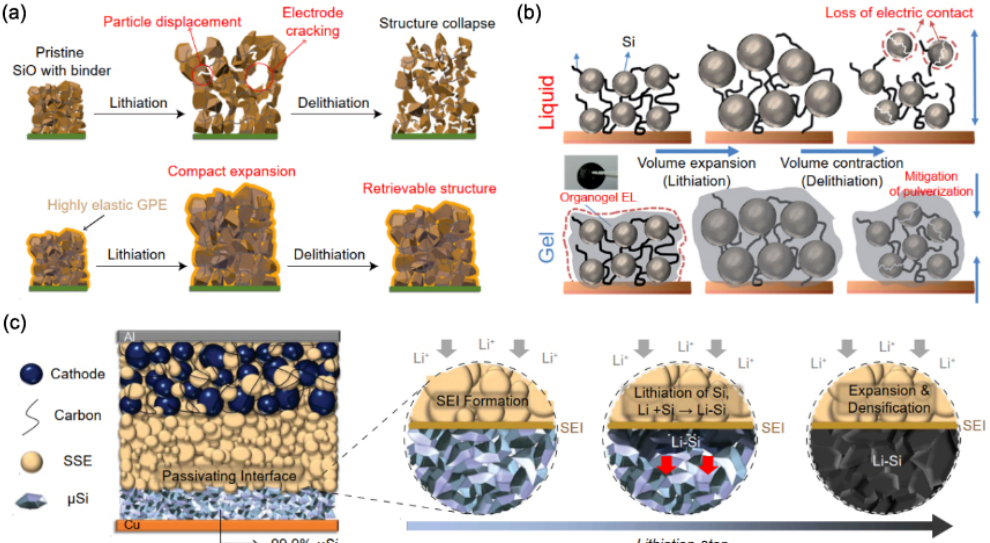
Figure 12 (a) Schematic illustration of an elastic gel polymer electrolyte (GPE)-incorporated SiO anode with a reliable electrode structure. Reproduced with permission from Ref. [179], © Huang, Q. Q. et al. 2019. (b) Morphological changes of silicon electrodes in liquid versus gel electrolytes during lithiation